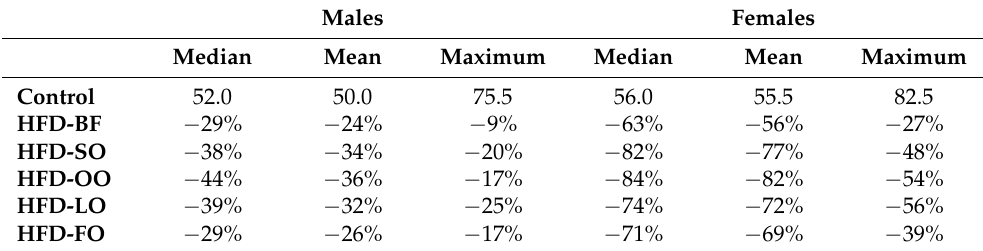
Table 2. The impact of different dietary fat qualities on the lifespan of male and female fruit flies. The median, mean and maximum lifespan data obtained for male and female w 1118 fruit flies fed a control sugar yeast (SY) diet are listed as the mean values in days (for each sex n = 2; N = 200 animals). The percentage differences from these values in response to the supplemented fat quality are